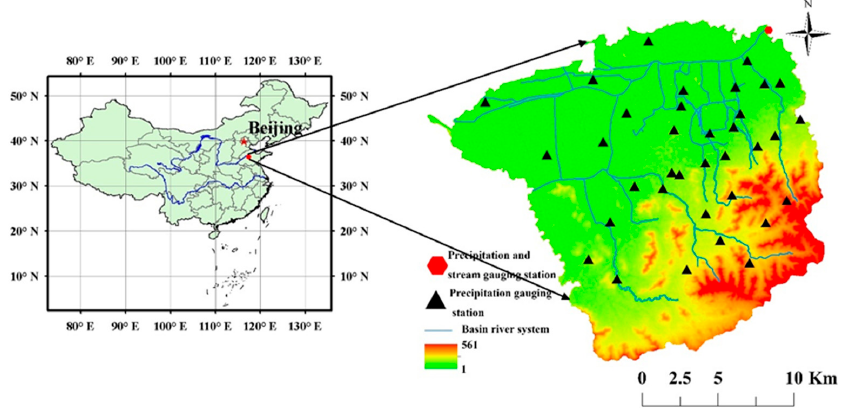
Figure 1. Map of the Huangtaiqiao basin.